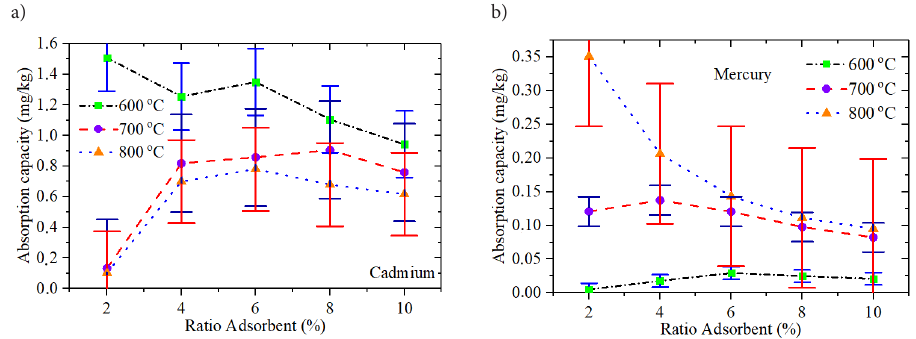
Figure 7. Total absorption capacity Hg and Cd with ratio and different